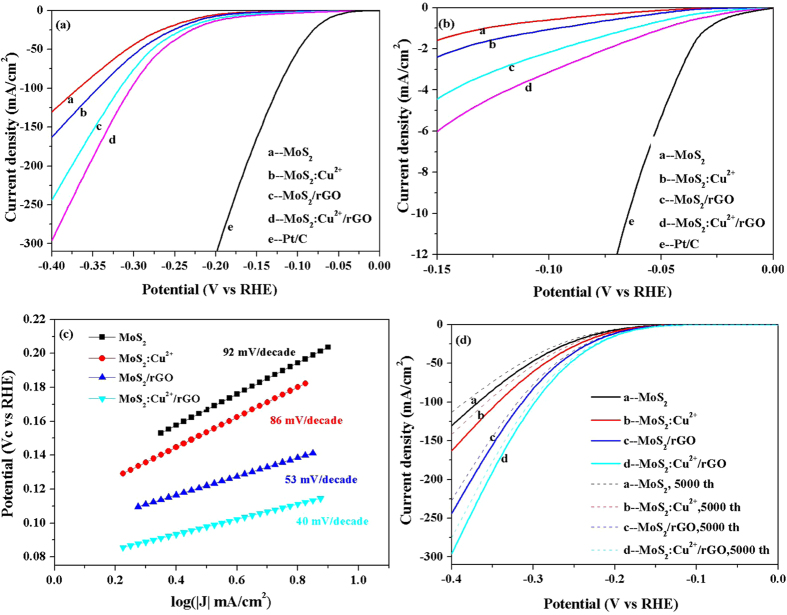
Polarization curves at (a) higher and (b) lower potentials, (c) The corresponding. Tafel plots from the polarization curves, and (d) Polarization curves initially and after 5000 cycles of continuous operation.